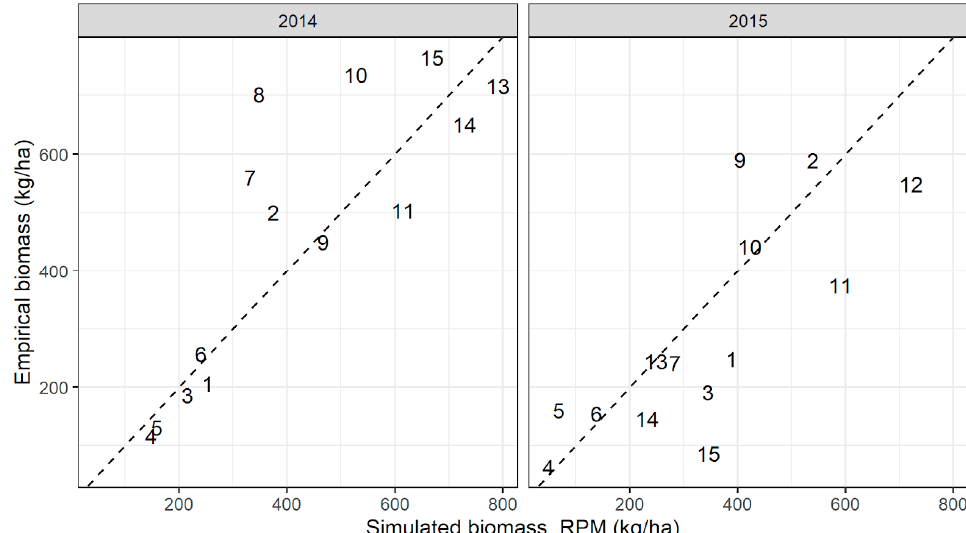
Figure A9. Biomass simulated by RPM when driven by time-varying precipitation data from CHIRPS at the site centroid and including empirical animal density at each site, compared to mean empirical biomass within sites.